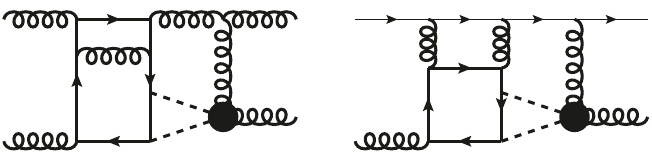
Figure 6 . Examples for diagrams for which we perform a direct expansion of the two-loop tadpole subgraph, so as to avoid having to compute two-loop building